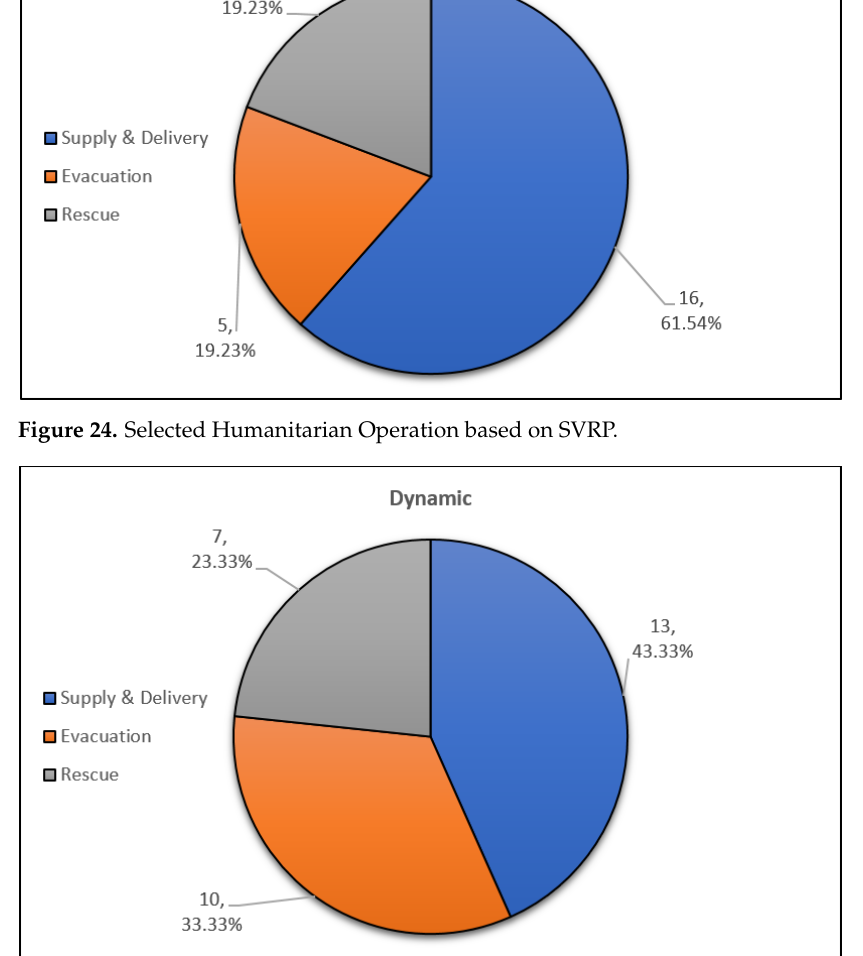
Figure 25. Selected Humanitarian Operation based on